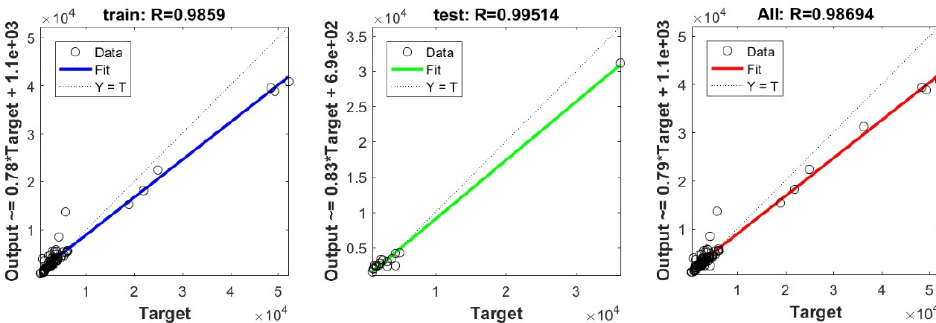
Figure A7. Scatter plots between target and output values by the PLS model.